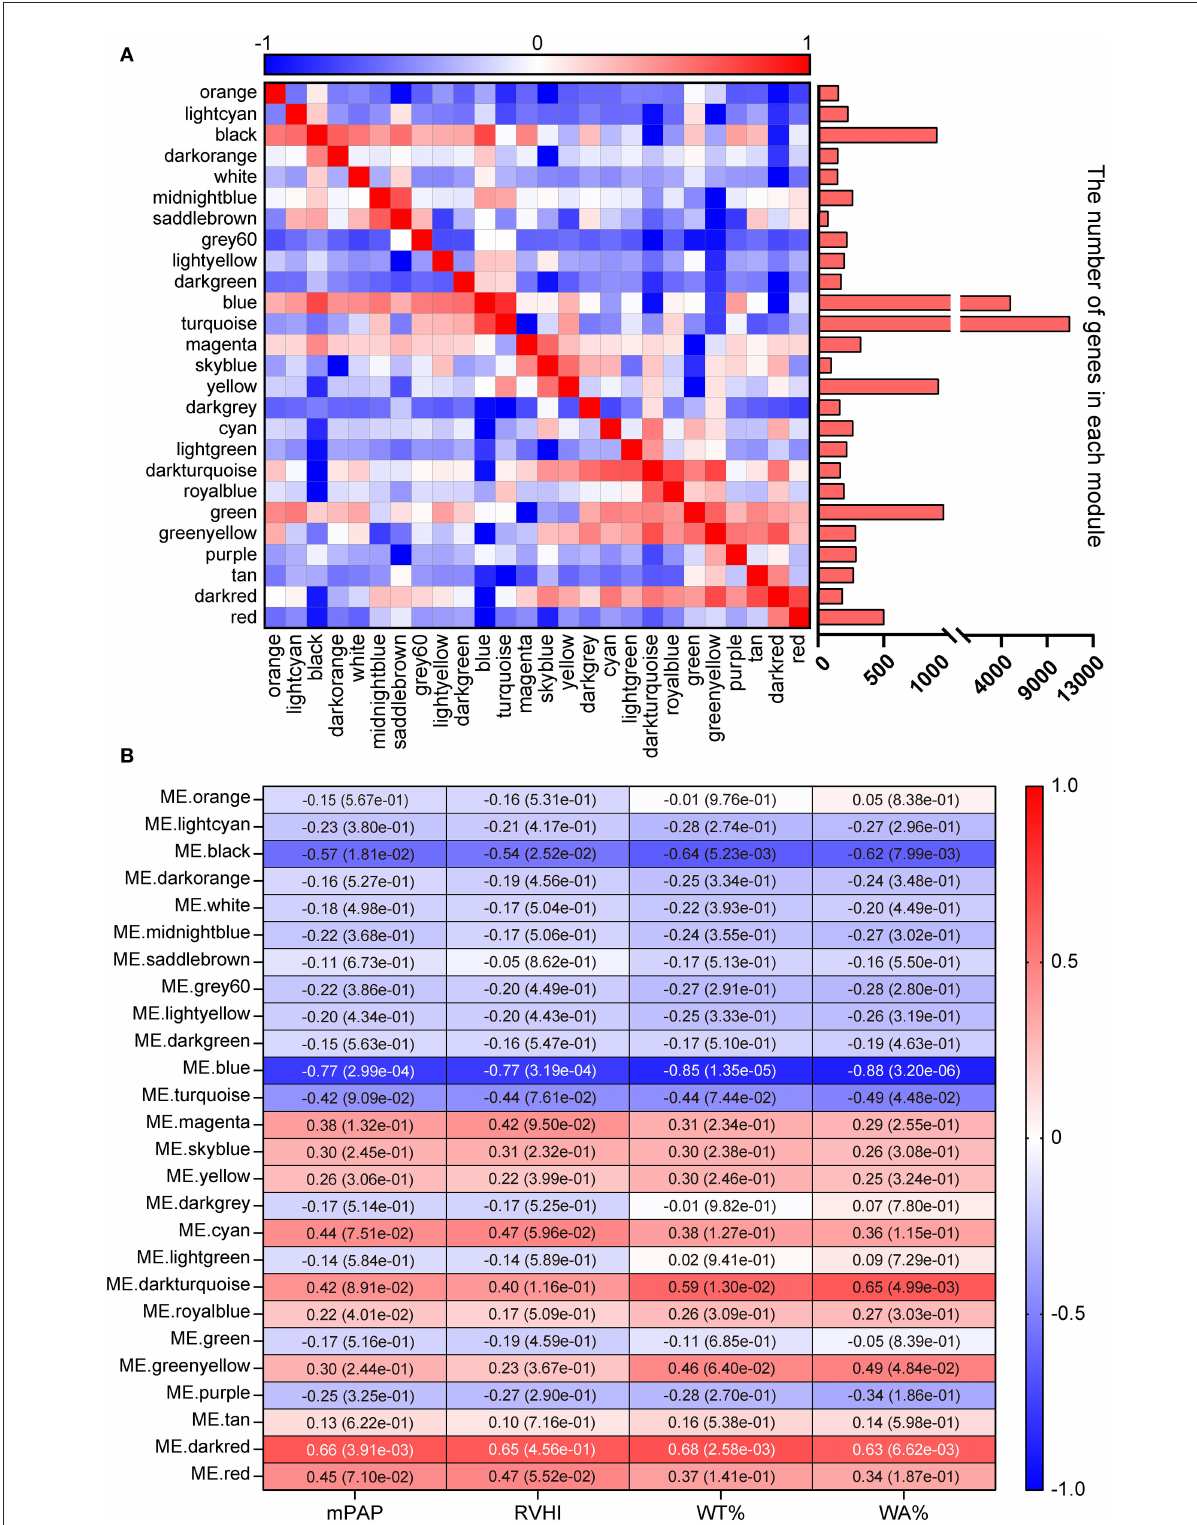
FIGURE2 Identification of key modules. (A) Heatmap plot of module eigengene. Red and blue represent a positive and negative correlation, respectively. The bar chart represents the number of genes in each module. (B) Heatmap plot of module–trait relationship. Rows and columns represent different gene co-expression modules and phenotypic traits. The dark red and blue module showed the strongest